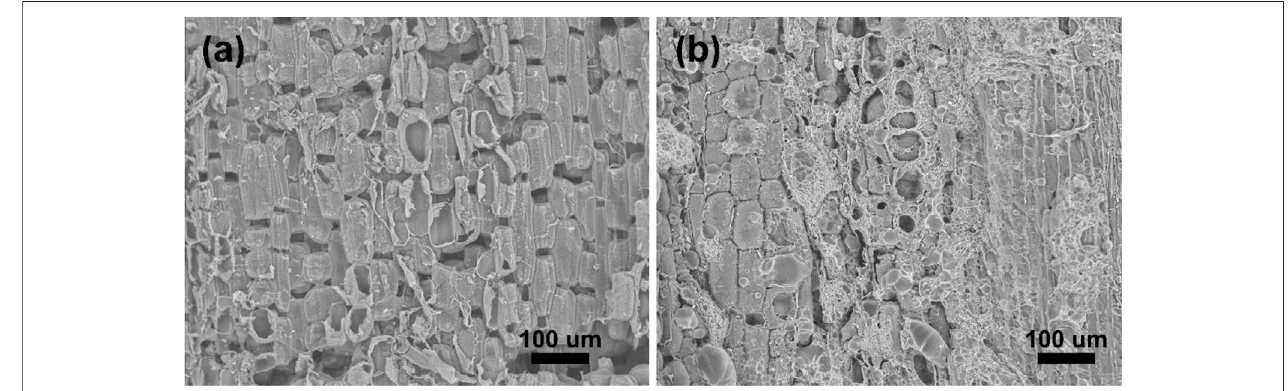
FIGURE 7 | SEM micrographs of untreated bamboo (A) and B/MP-5BL (B) char residues after cone calorimetry tests.